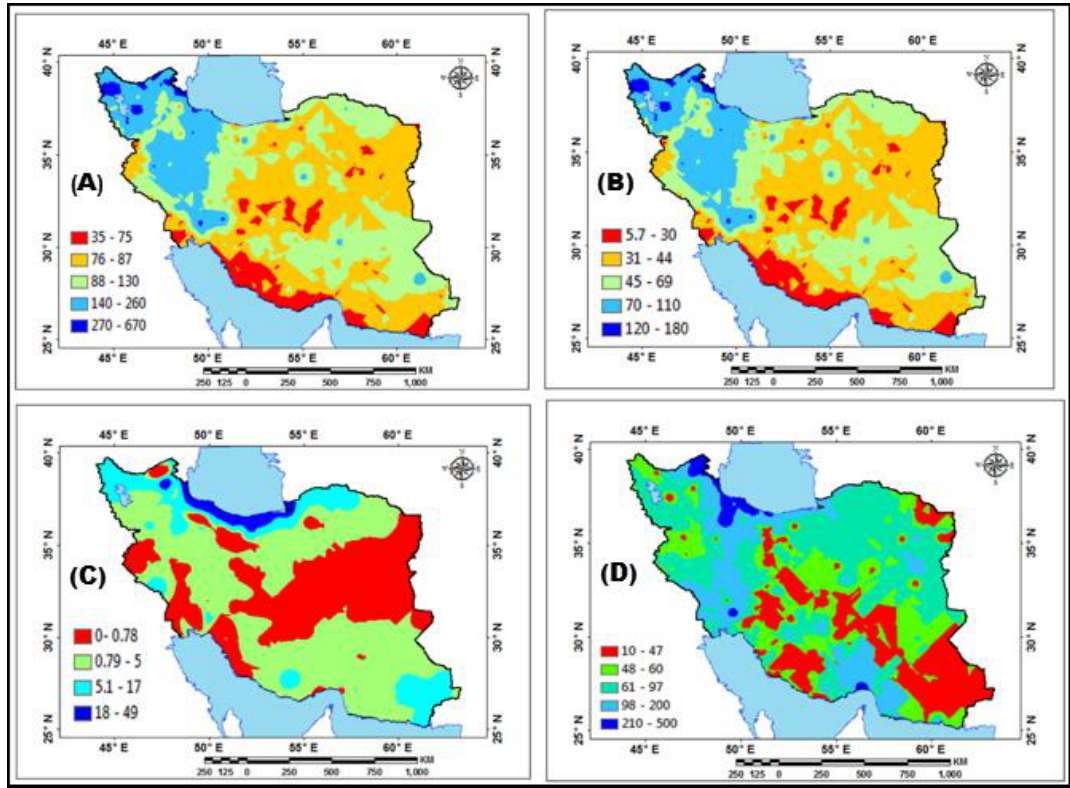
Figure 1. Rainfall seasonal distribution in Iran: ( A ): Winter; ( B ): Spring; ( C ): Summer and ( D ): Autumn.